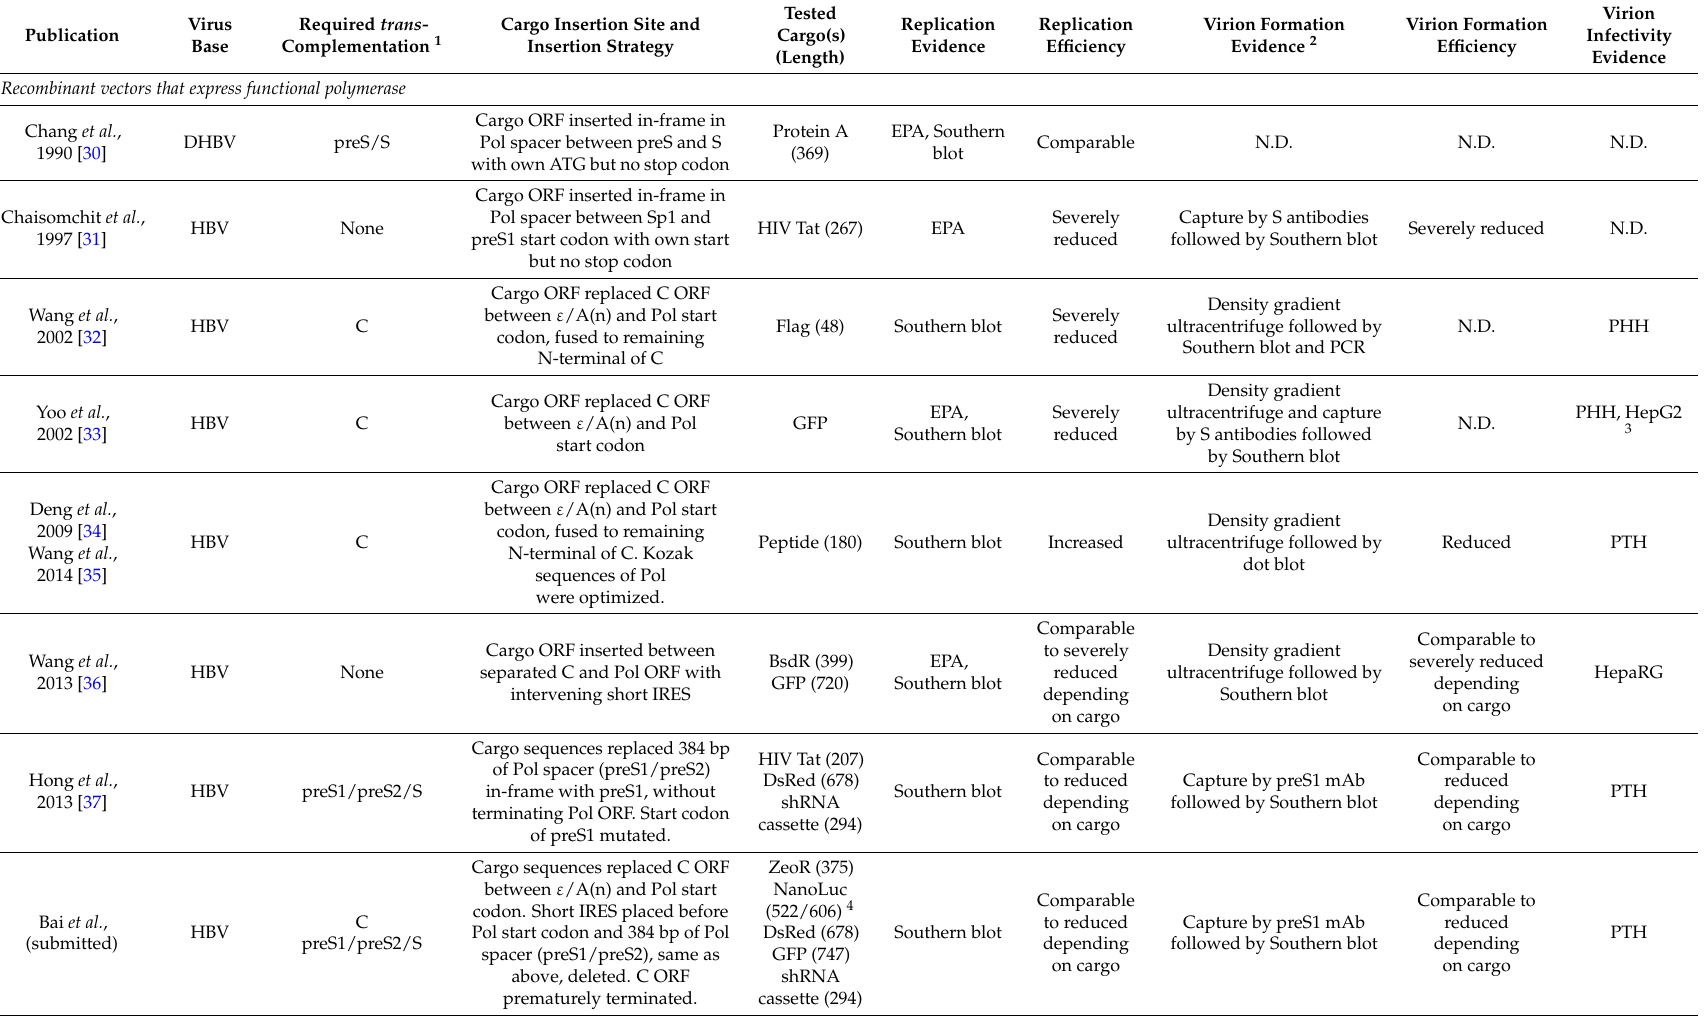
Table 1. Listing and comparison of recombinant hepadnavirus vector